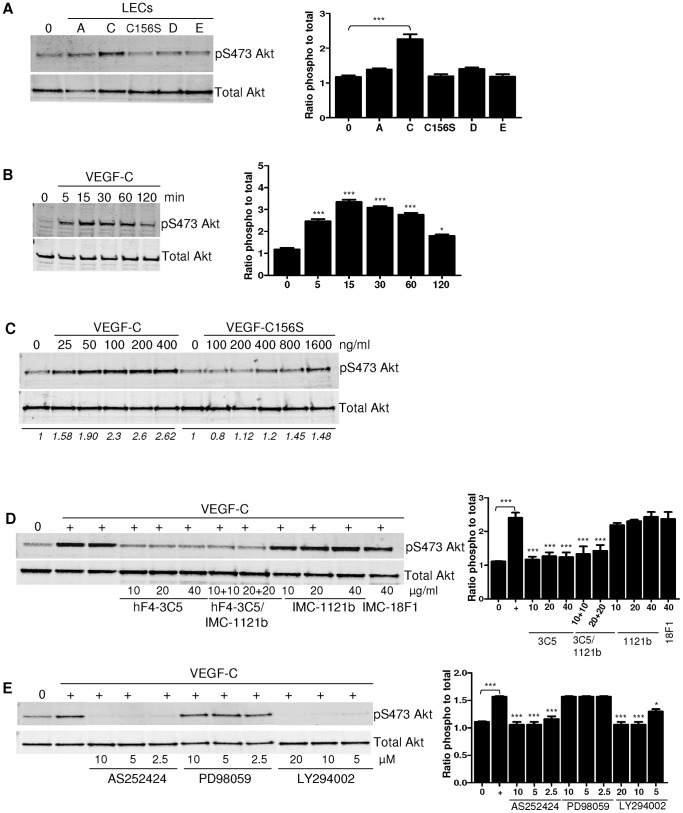
VEGF-C induces PI3K-dependent Akt phosphorylation via VEGFR-3 in LECs. A, Western blotting analysis of phosphorylated Akt (S473) in prostatic LECs following a 15 minute ligand stimulation: VEGF-A (100 ng/ml), VEGF-C (100 ng/ml), VEGF-C156S (250 ng/ml), VEGF-D (250 ng/ml) and VEGF-E (100 ng/ml). B, Time course for Akt phosphorylation (S473) in LECs after VEGF-C (100 ng/ml) stimulation. C, Concentration-dependent phosphorylation of LEC Akt (S473) following 15 minute stimulation with VEGF-C or VEGF-C156S. D, Effect of inhibition of VEGFR-3 (hF4-3C5), VEGFR-2 (IMC-1121b) or VEGFR-1 (IMC-18F1) on LEC Akt (S473) phosphorylation in response to VEGF-C (100 ng/ml). E, Effect of inhibition of PI3K (AS252424, LY294002) or Raf/MEK (PD98059) on Akt (S473) phosphorylation in LECs in response to VEGF-C (100 ng/ml). Serum-free vehicle treated LEC lysate is indicated by ‘0′ in all blots. n = 3. Densitometry analysis is shown for each blot either italicized or graphed; where integrated intensity of phosphorylated molecules was firstly compared to that of the total target protein for each sample, and then expressed as fold increase in integrated density compared to VEGF-C treated control samples. P value calculated using one-way ANOVA. For panels A-B data is compared to time-point zero; panels D-E data is compared to VEGF-C treated control, except where indicated for serum free/VEGF-C treatment comparison. Columns: mean; bars: s.e.m.; P<0.05 (*), P<0.01 (**); P<0.001 (***).